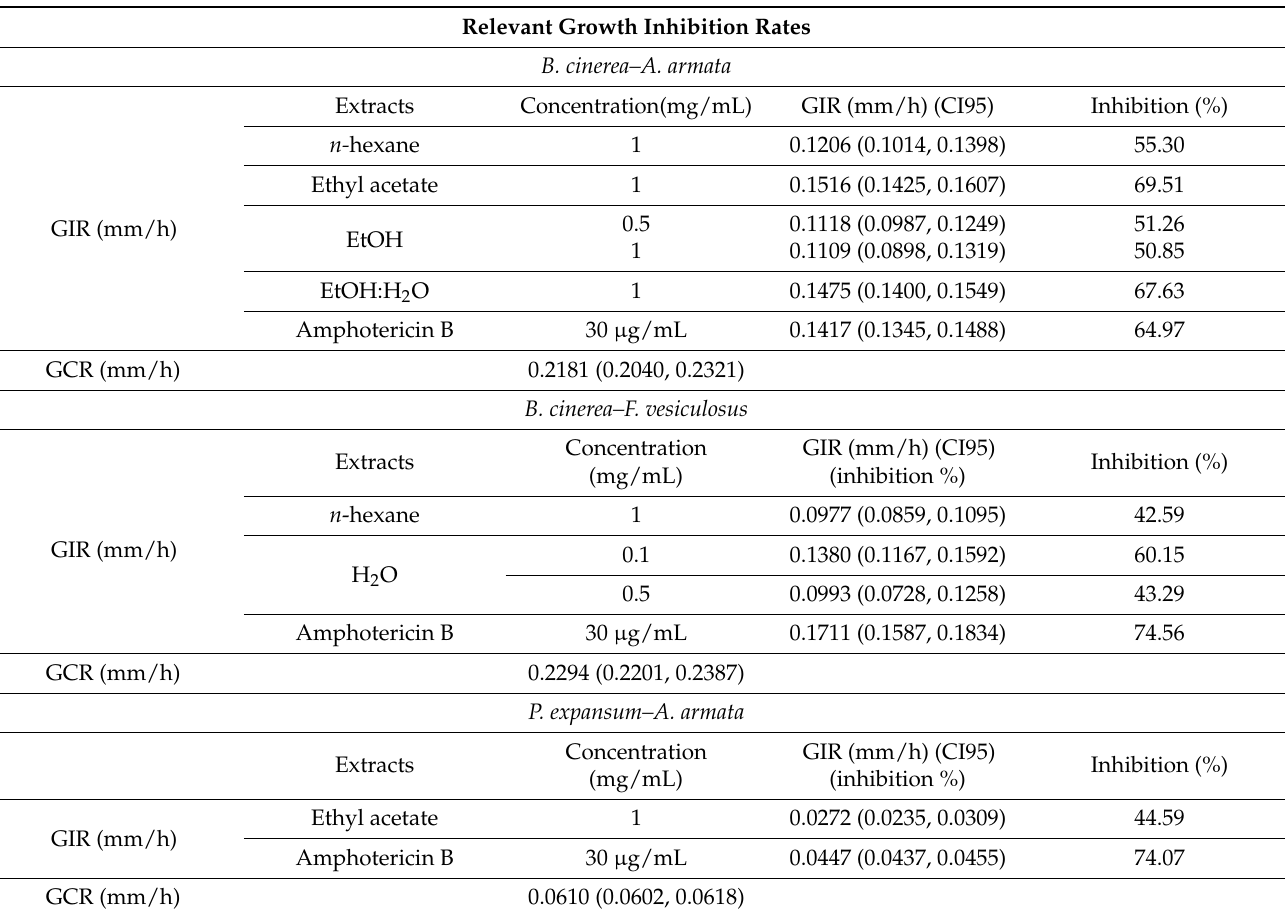
Table 2. Relevant growth inhibition rates (GIRs) in mm/h obtained in the poisoned food technique assay for the n -hexane, ethyl acetate, ethanolic, and hydroethanolic extracts of Asparagopsis armata at 0.5 and 1 mg/mL and the n -hexane and aqueous extracts of Fucus vesiculosus against Botrytis cinerea and Penicillium expansum . The GIR is followed by the confidence interval [CI95] and the inhibition percentage in comparison with the control growth rate (CGR), which is also indicated for each